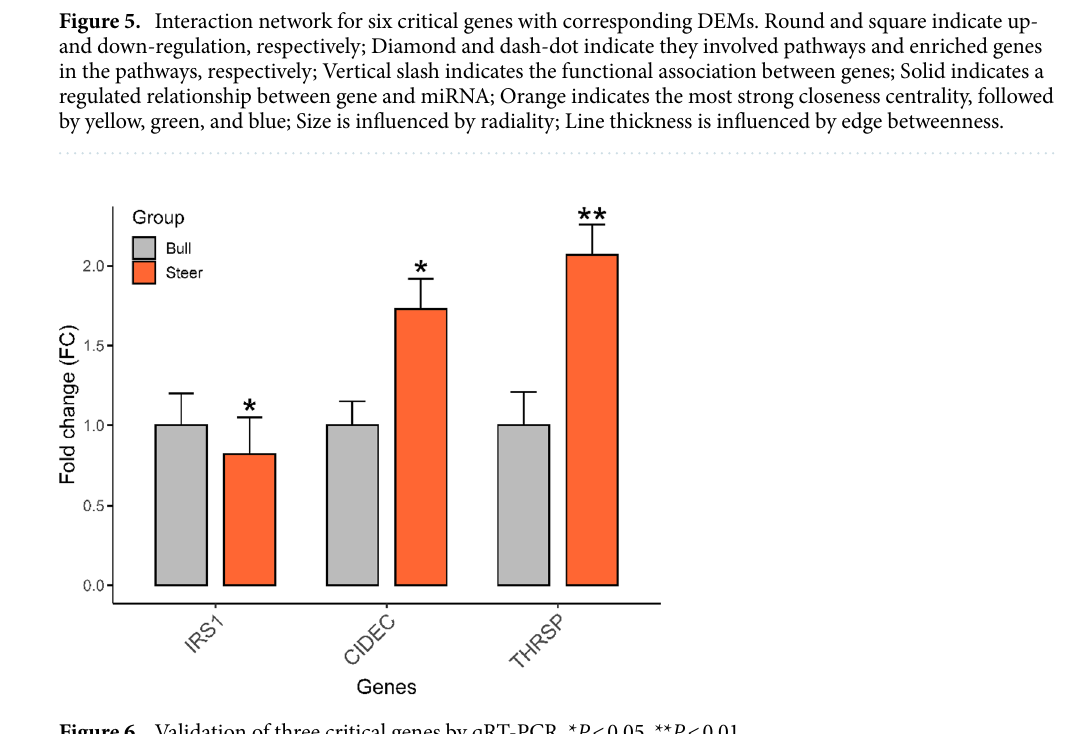
Figure 6. Validation of three critical genes by qRT-PCR, * P < 0.05, ** P <